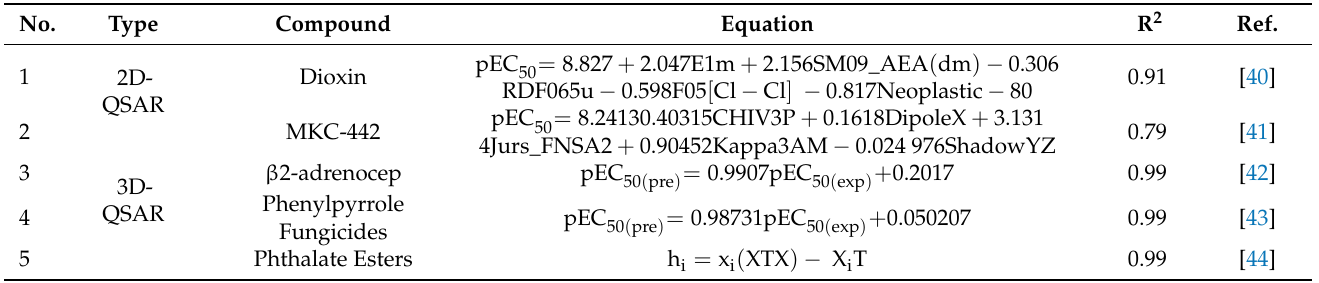
Table 3. Common applications of QSAR with different dimensions in environmental contaminants.